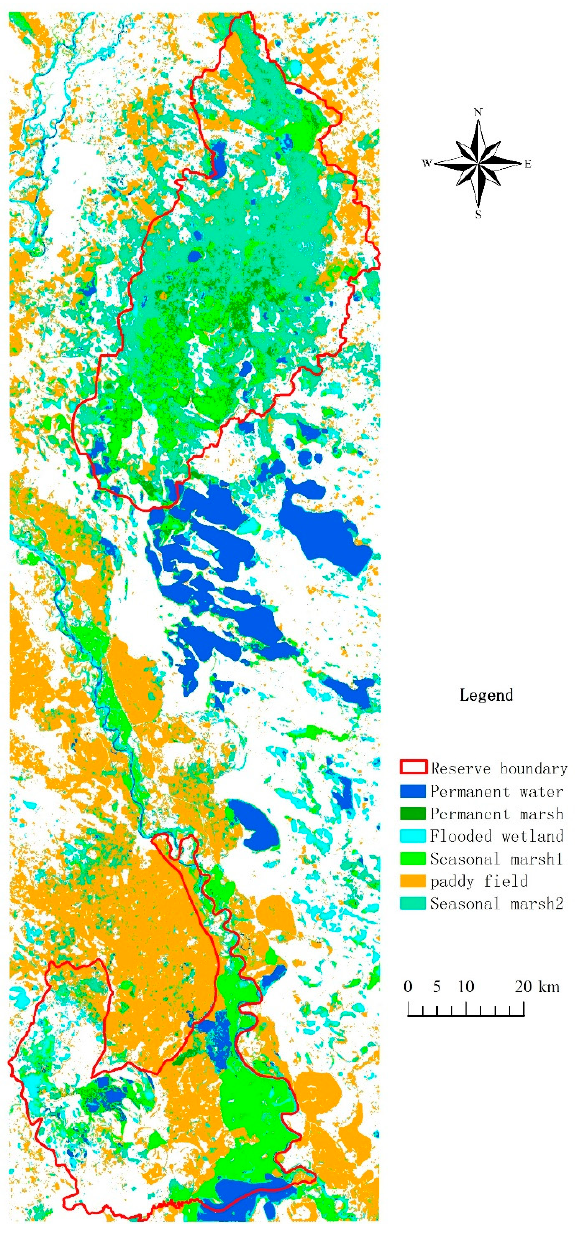
Figure 9. Annual wetland classification result based on seasonal-rule-based wetland classification method.